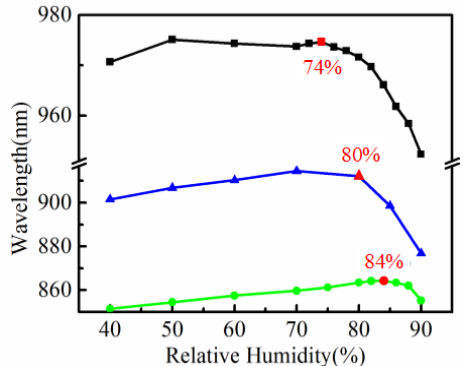
Figure 4. Nonmonotonic shift of the resonant wavelengths with RH increasing for fiber SPR sensors with initial wavelengths of 864.22, 912.10 and 974.64 nm, respectively. The red numbers indicate the inflection points of the sensors.